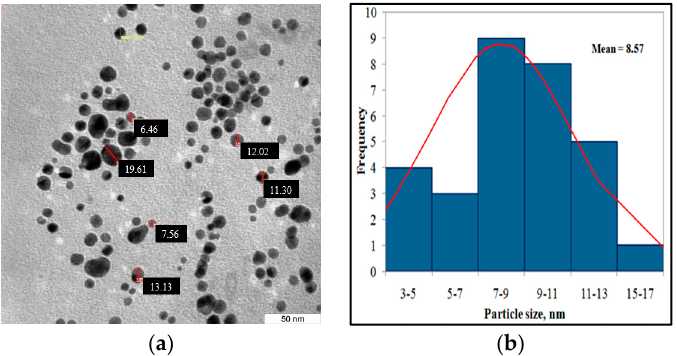
Figure 6. ( a ) A transmission electron microscopy (TEM) image of the cetyltrimethylammonium bromide (CTAB)-stabilized gold nanoparticles (scale bar: 50 nm); ( b ) Size distribution histogram.